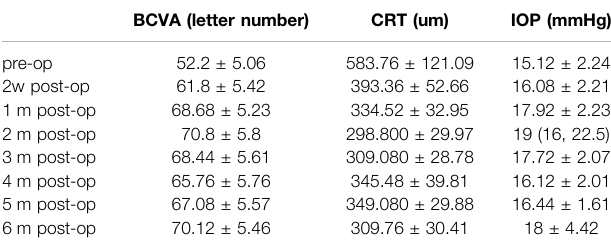
TABLE 2 | Results of BCVA, CRT, and IOP at each time point before and after surgery (x ±